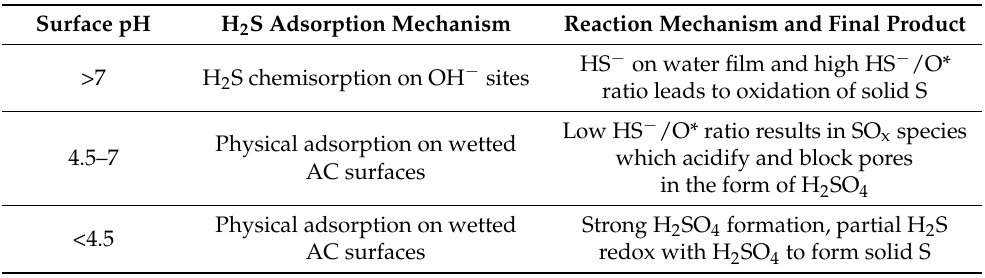
Table 4. H 2 S adsorption and reaction mechanisms of carbon surface defined by pH on activated carbon